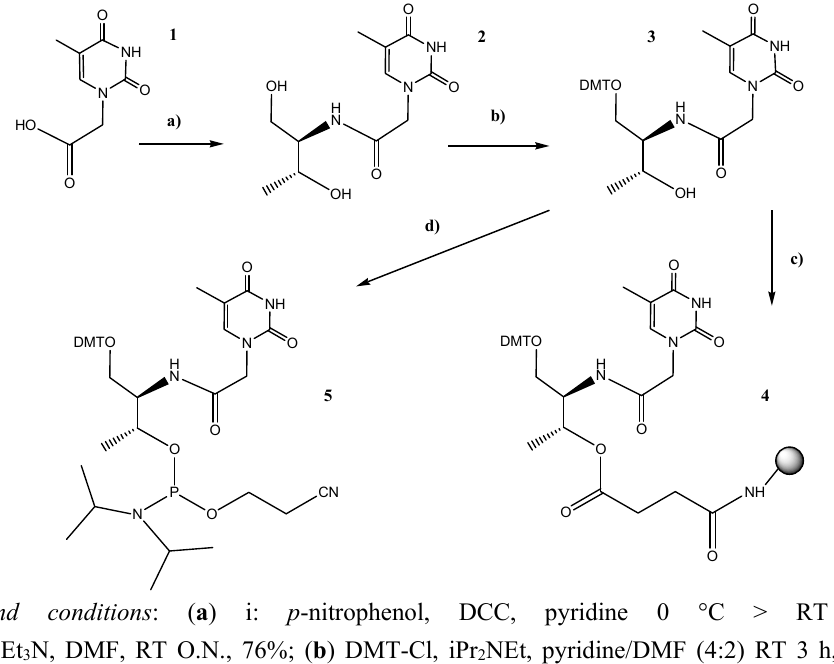
Figure 1. Schematic synthesis of the L -threoninol-thymine, the phoshoramidite and the functionalized solid